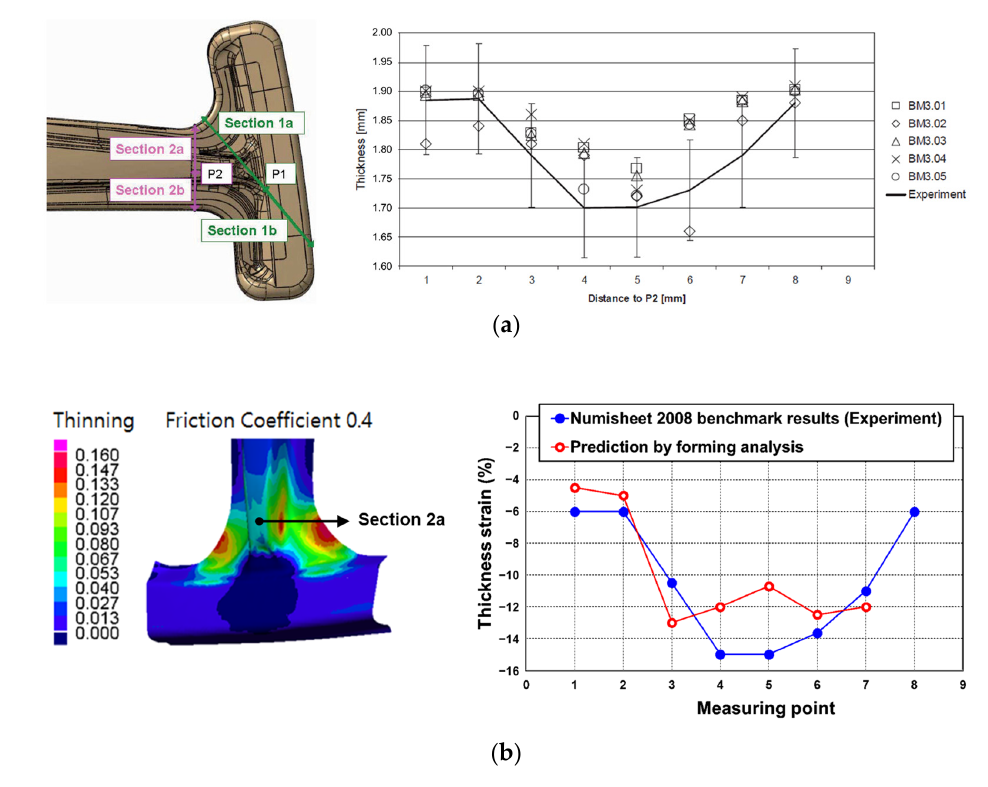
Figure 10. ( a ) Thickness in Section 2a of the B-pillar from the Numisheet 2008 benchmark results; ( b ) thickness strain in Section 2a from the forming analysis compared with the Numisheet 2008 benchmark results.